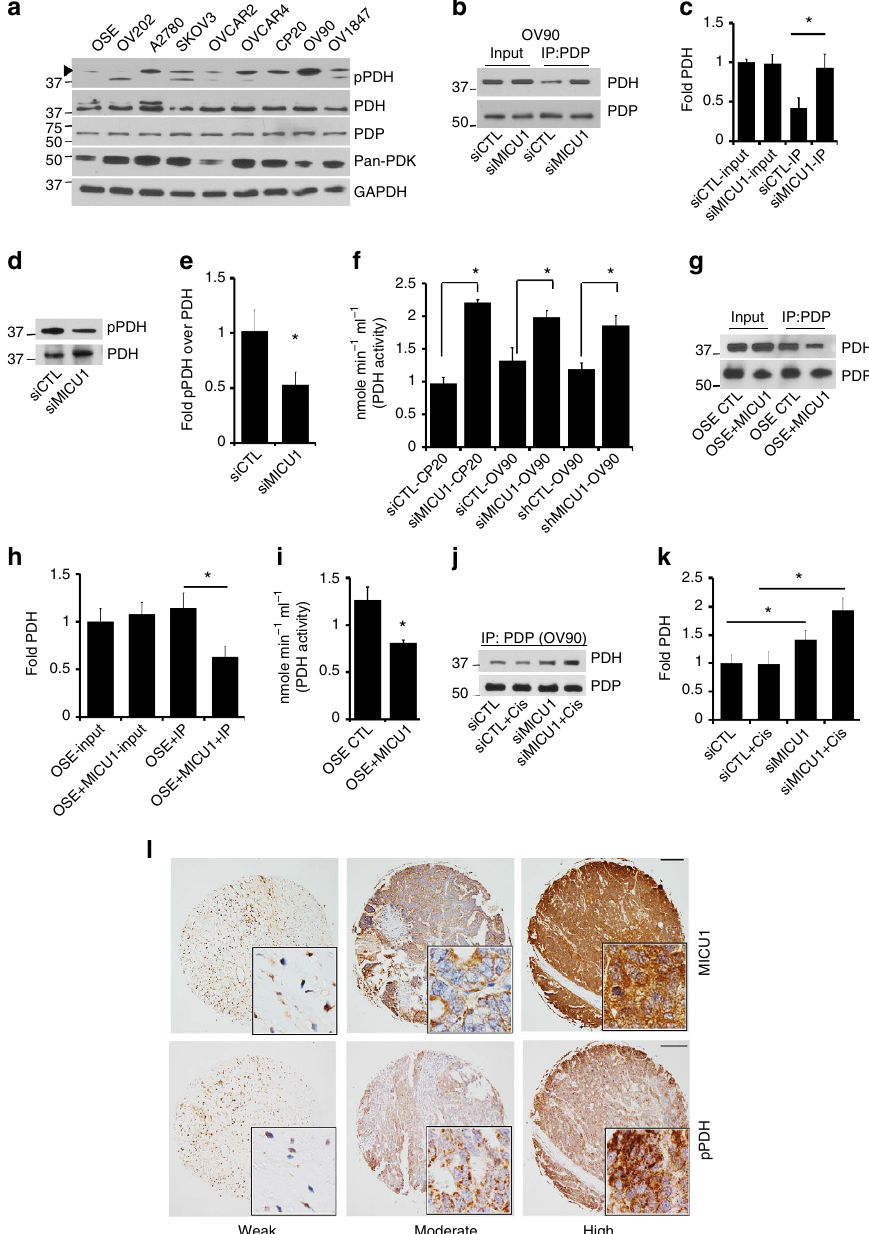
Figure 6 | MICU1 silencing restores pyruvate dehydrogenase activity. ( a ) Immunoblot analysis for phospho pyruvate dehydrogenase (pPDH[ser293]), pyruvate dehydrogenase (PDH), pyruvate dehydrogenase phosphatase (PDP) and pan-pyruvate dehydrogenase kinase (pan-PDK) in OSE and various OvCa cell lines. GAPDH was used as a loading control. ( b ) MICU1 silencing increases PDP-PDH interaction. Immunoprecipitation of PDP followed by immunoblot for PDH and PDP in siCTL-OV90 and siMICU1-OV90 cells. ( c ) Quantification for PDH band intensity measurement using ImageJ software normalized against PDP. Values represent mean ± s.d. ( d ) MICU1 silencing causes diminished phosphorylation status of PDH. Immunoblot for pPDH in whole cell lysates from siCTL-OV90 and siMICU1-OV90 cells and compared against PDH. ( e ) Densitometry analysis of ( d ) by ImageJ, pPDH band intensity is normalized to corresponding PDH levels and represented as mean fold change ± s.d. ( f ) Pyruvate dehydrogenase (PDH) activity was measured in MICU1 siRNA treated OV90 or CP20 cells and MICU1 knockdown OV90 cells and values represent mean ± s.d. ( g ) MICU1 overexpression decreases PDP and PDH interaction. Immunoprecipitation of PDP followed by immunoblot for PDH and PDP in Flag-MICU1 expressing OSE cells. ( h ) Quantification for PDH band intensity measurement using ImageJ software normalized against PDP and values represent mean ± s.d. ( i ) In Flag-MICU1 expressing OSE cells, PDH activity was measured and values represent mean ± s.d. ( j ) MICU1 silencing increases PDP and PDH interaction upon cisplatin (10 m M) treatment. Immunoprecipitation of PDP followed by immunoblot for PDH and PDP in siCTL-OV90 and siMICU1-OV90 cells. ( k ) Quantification for PDH band intensity measurement using ImageJ software normalized against PDP. ( l ) Immunohistochemical staining of a tissue microarray of drug resistant epithelial OvCa samples for MICU1 (1:150) or pPDH (1:200). Representative images taken at (cid:2) 4 magnification are shown of (i) weak, (ii) moderate and (iii) high staining. Inset shows magnified areas of individual IHC stains taken at (cid:2) 20 magnification. The bar represents 100 m m. * P o 0.05 statistically significant when compared to the respective controls, using two-sided Student’s t -test with unequal variances. Horizontal bar represents statistical comparison between respective groups. All the experiments were repeated independently at least three times and in triplicates. NATURE COMMUNICATIONS|8:14634|DOI: